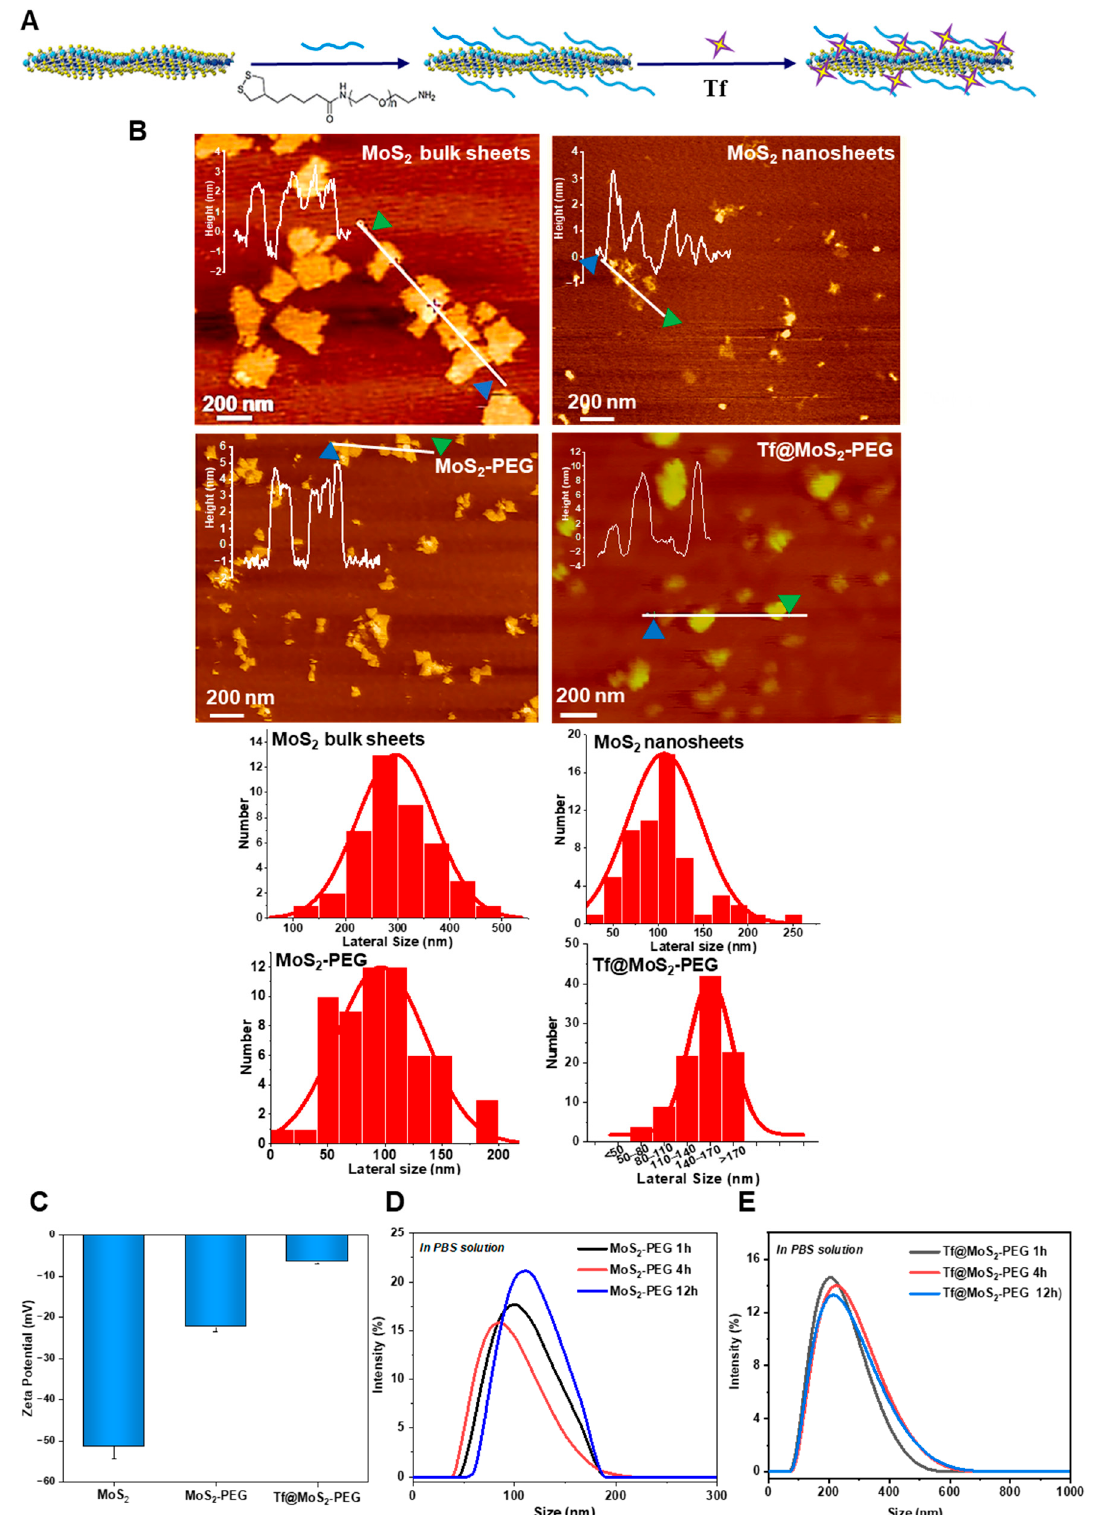
Figure 1. ( A ) Schematic illustration of the synthesis of Tf@MoS 2 -PEG nanosheets. ( B ) AFM images of MoS 2 bulk sheets before ultrasonication, MoS 2 nanosheets, MoS 2 -PEG, and Tf@MoS 2 -PEG nanosheets. The insert figures indicate the height measurements along with the line profiles. The histograms show the lateral size distribution of MoS 2 bulk sheets, MoS 2 nanosheets, MoS 2 -PEG, and Tf@MoS 2 -PEG NSs. ( C ) Zeta potential of MoS 2 , MoS 2 -PEG, and Tf@MoS 2 -PEG in deionized water. The hydrodynamic diameters of MoS 2 -PEG ( D ) and Tf@ MoS 2 -PEG ( E ) in PBS solution.